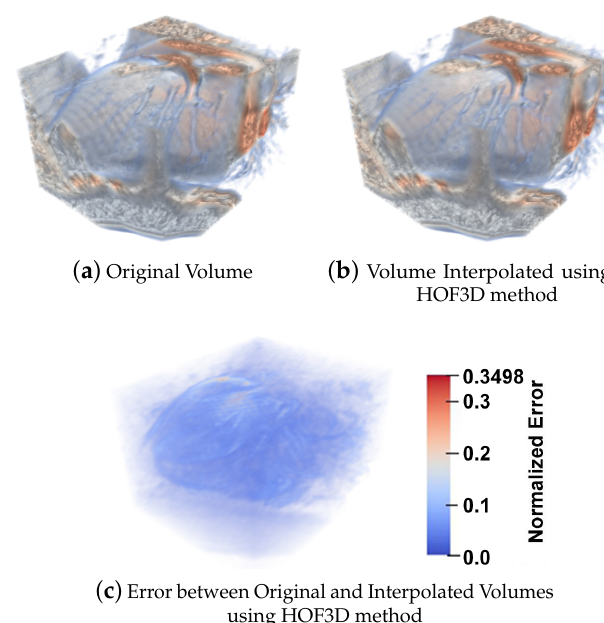
Figure 11. A cardiac CT volume showing the original volume, the Interpolated Volume using the HOF3D method and the error between the original volume and its interpolated result.